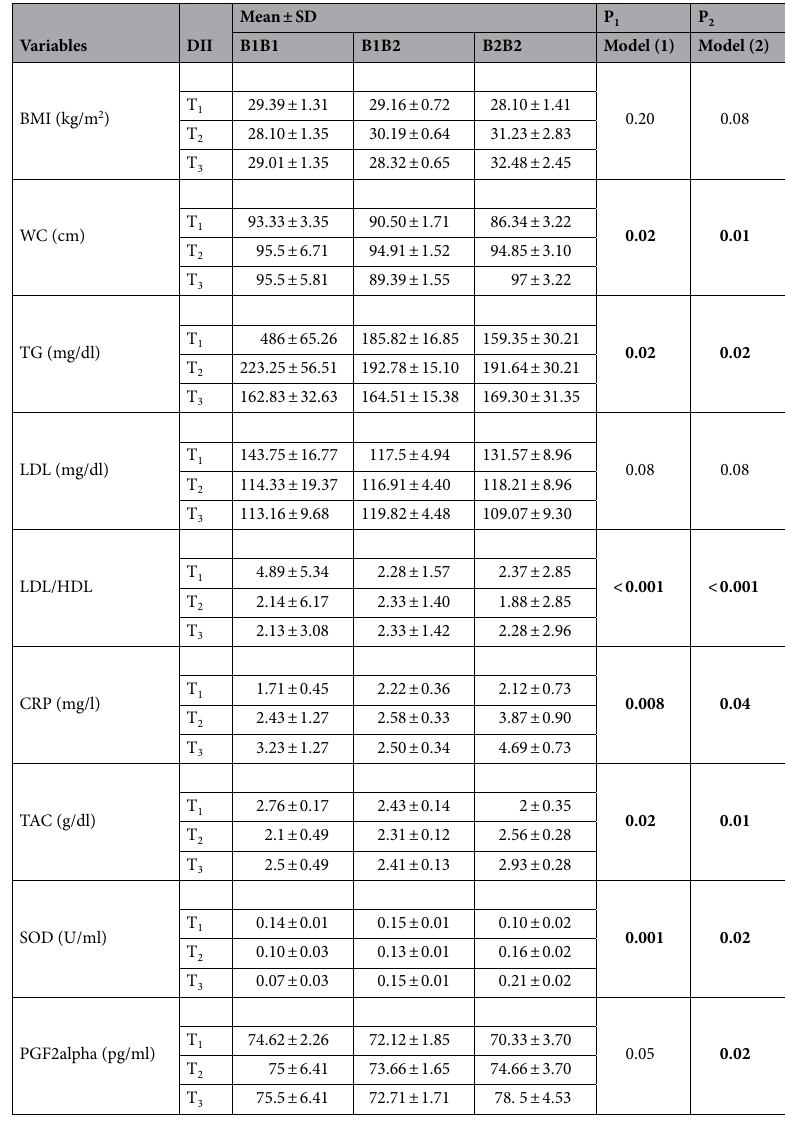
Table 5. Mean values of CVD risk factors across CETP genotypes (B1B, B1B2, B2B2) based on low and high DII intake. Mean values of cardiovascular risk factors across CETP genotypes (B1B1, B1B2, B2B2) based on tertiles of DII intake. P1: P-value for curd model; P2: P-value for the adjusted model by age, gender, physical activity, smoking, alcohol consumption, and familial history of diabetes. Bold values denote statistical significance at the p < 0.05